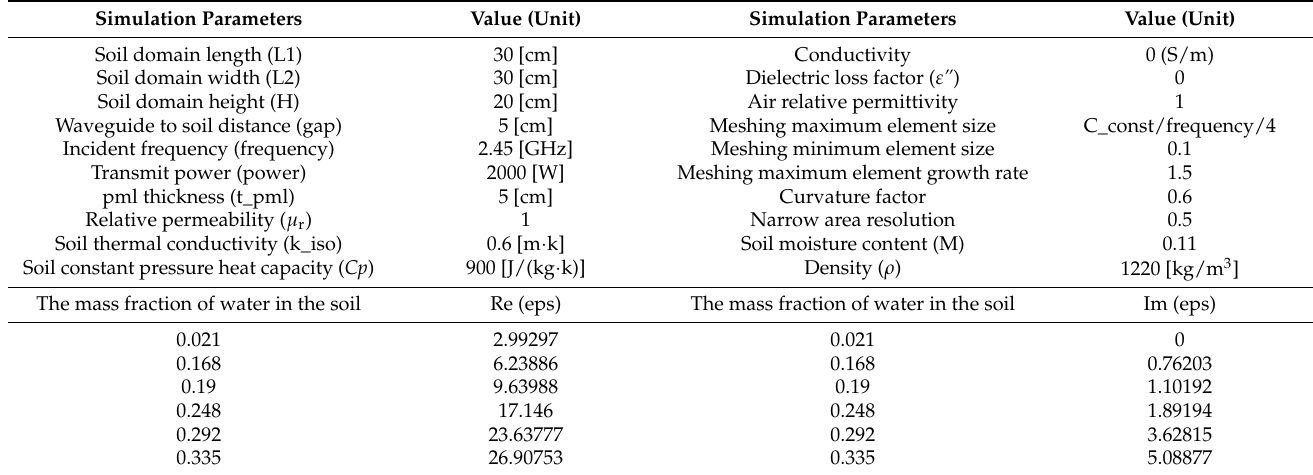
Table 1. Main parameter settings of microwave soil irradiation temperature field simulation.